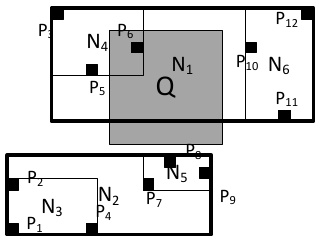
Figure 3. An optimal partition of a dataset